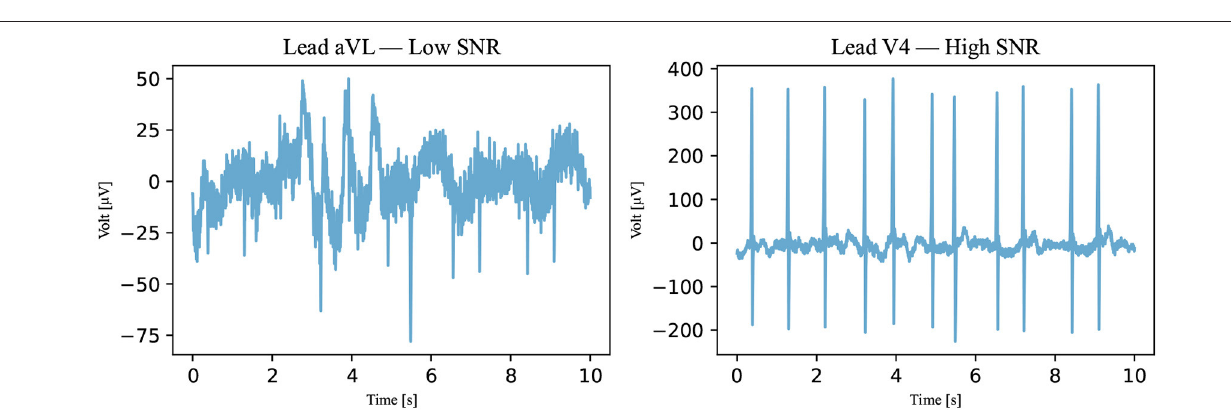
SNR threshold. The training data set results of the algorithms can be seen in Table 3